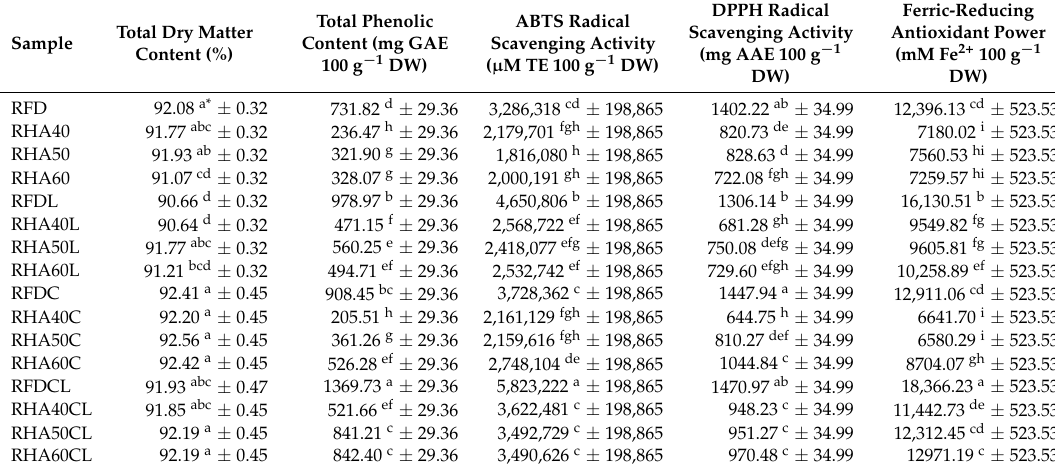
Table 4. The total dry matter content, total phenolic content, ABTS radical scavenging activity, DPPH radical scavenging activity, and ferric-reducing antioxidant power of the yacon chips produced from red yacon